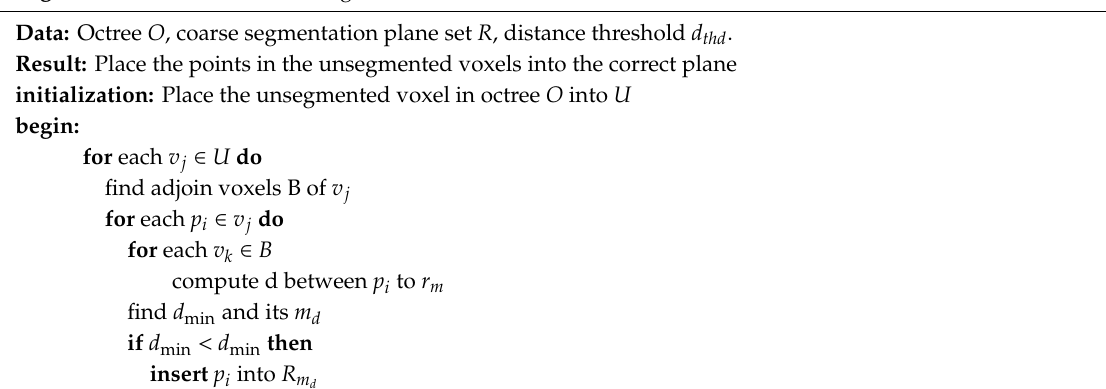
Algorithm 1: Unlabeled voxel